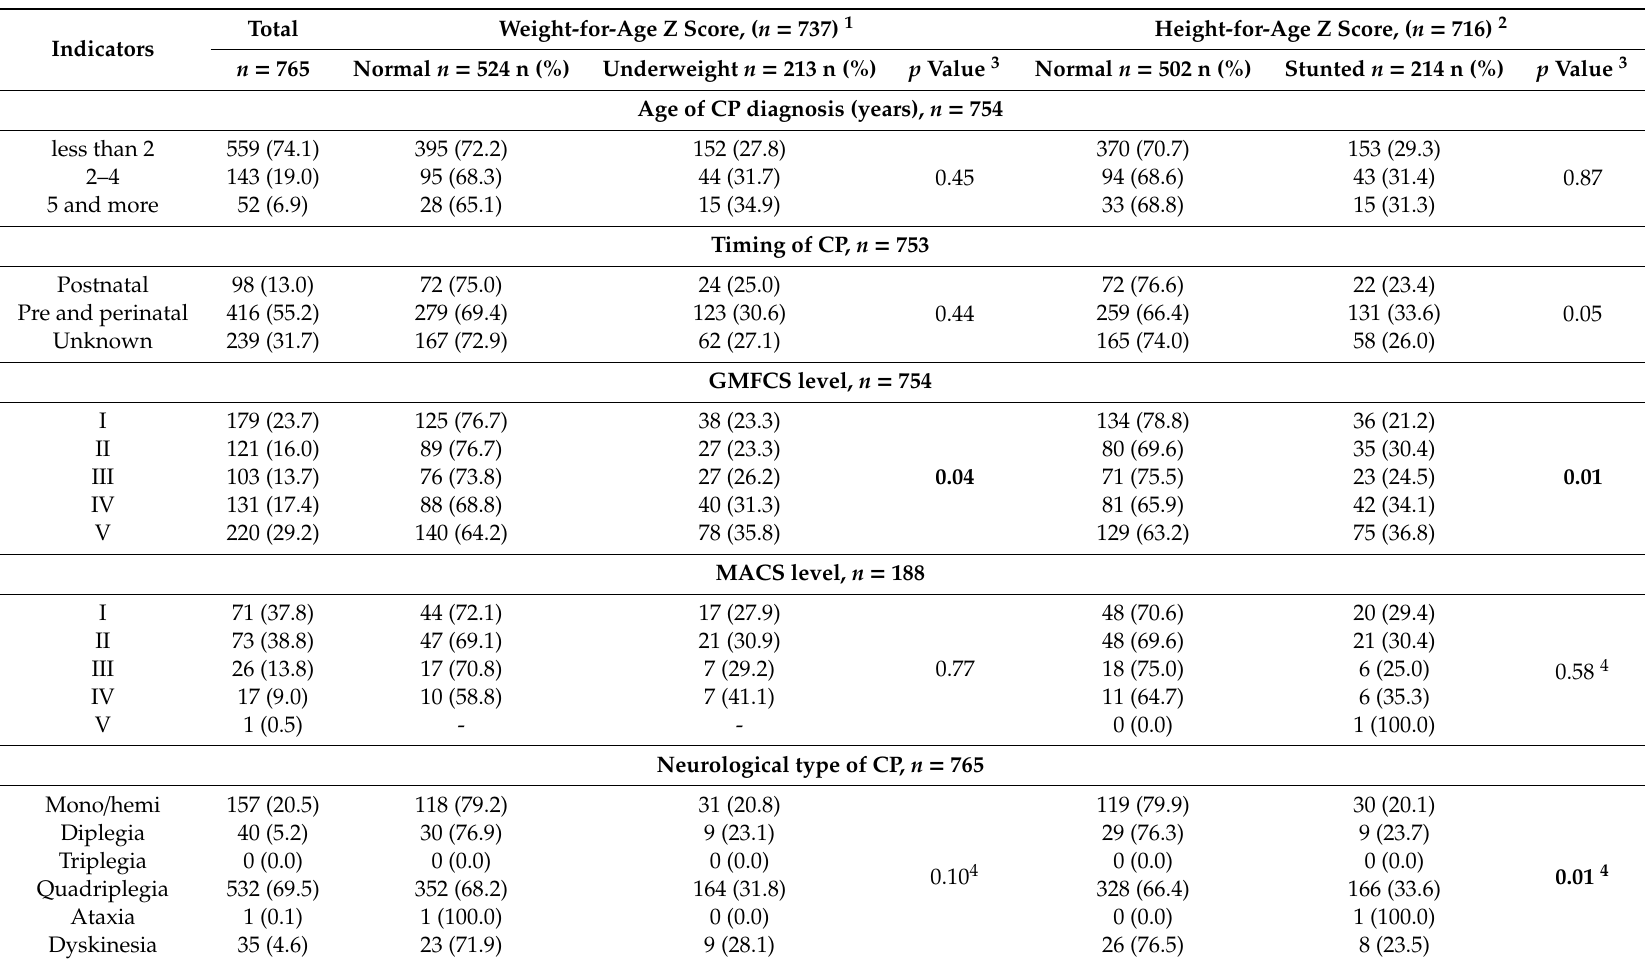
Table 3. Clinical characteristics and nutritional status of the children with Cerebral Palsy